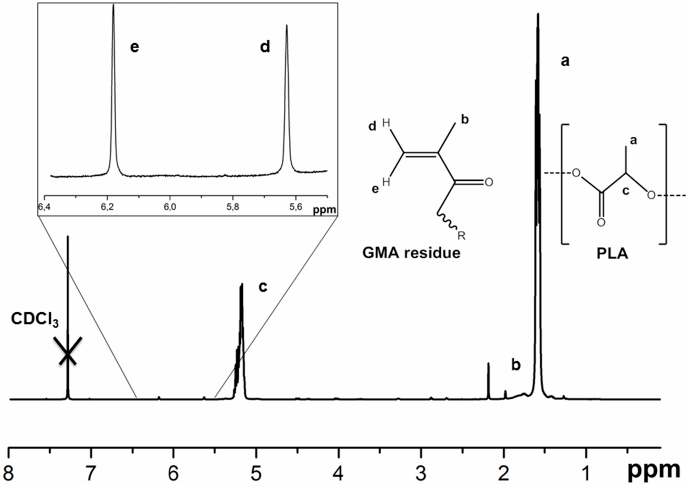
Figure 5. 1H NMR of the PLA film modified with glycidyl methacrylate GMA and dissolved in CDCl 3 . Both signals of PLA (a,c) and GMA residue (b,d,e) can be observed.